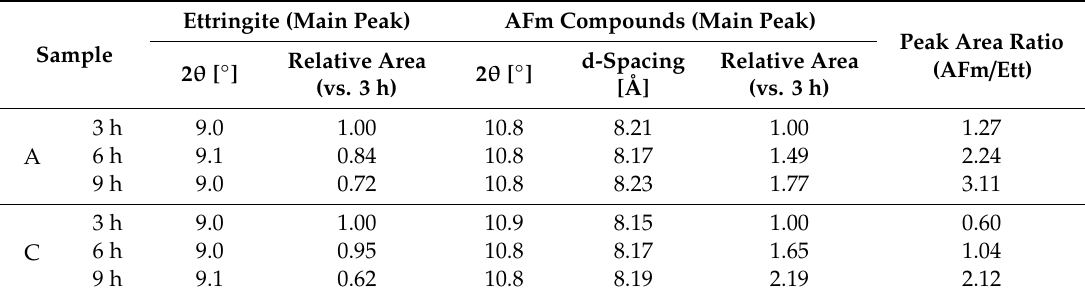
Figure 2. X-ray diffraction (XRD) patterns of A and C at 3 h, 6 h and 9 h after the start of hydration; brownmillerite (tetracalcium aluminoferrite, C 4 AF), Alite (tricalcium silicate, C 3 S). Table 3. XRD patterns of paste A and C at 3, 6 and 9 h after the start of